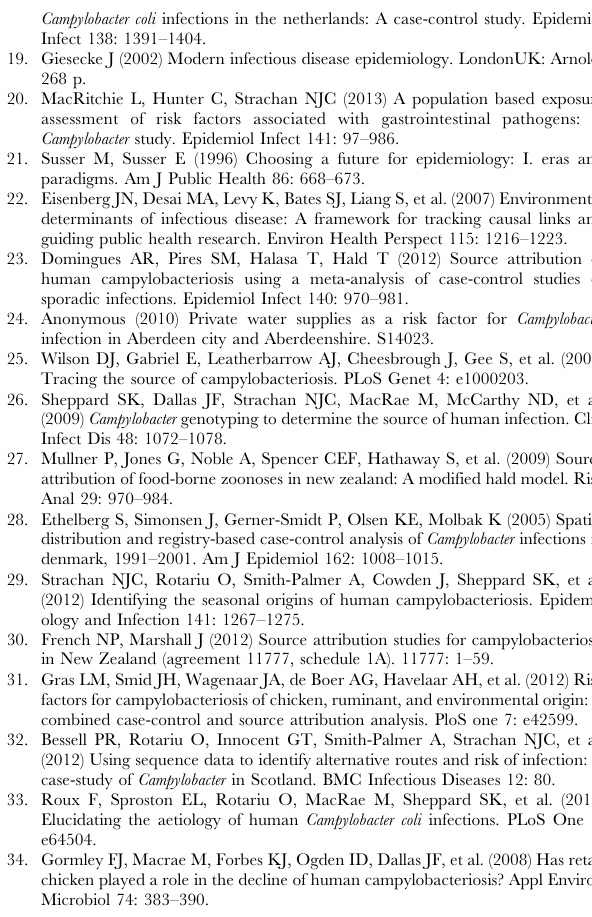
Table S2 Urban-rural ratios of clinical cases stratified by age. Table S3 Case-case clinical